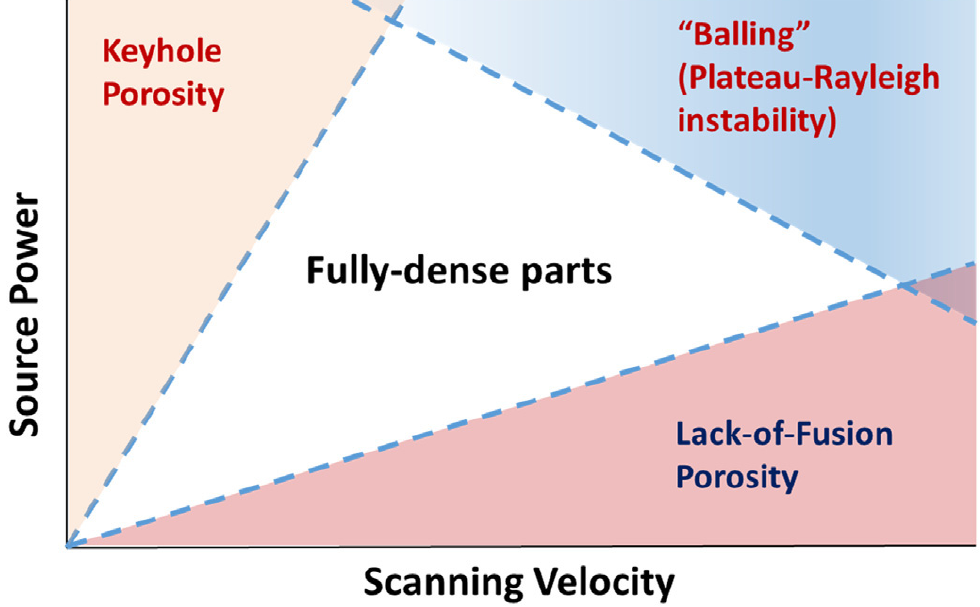
Figure 4. Illustration of processing parameter influence on porosity. Reprinted with permission from ref. [17]. Copyright 2020 Elsevier.